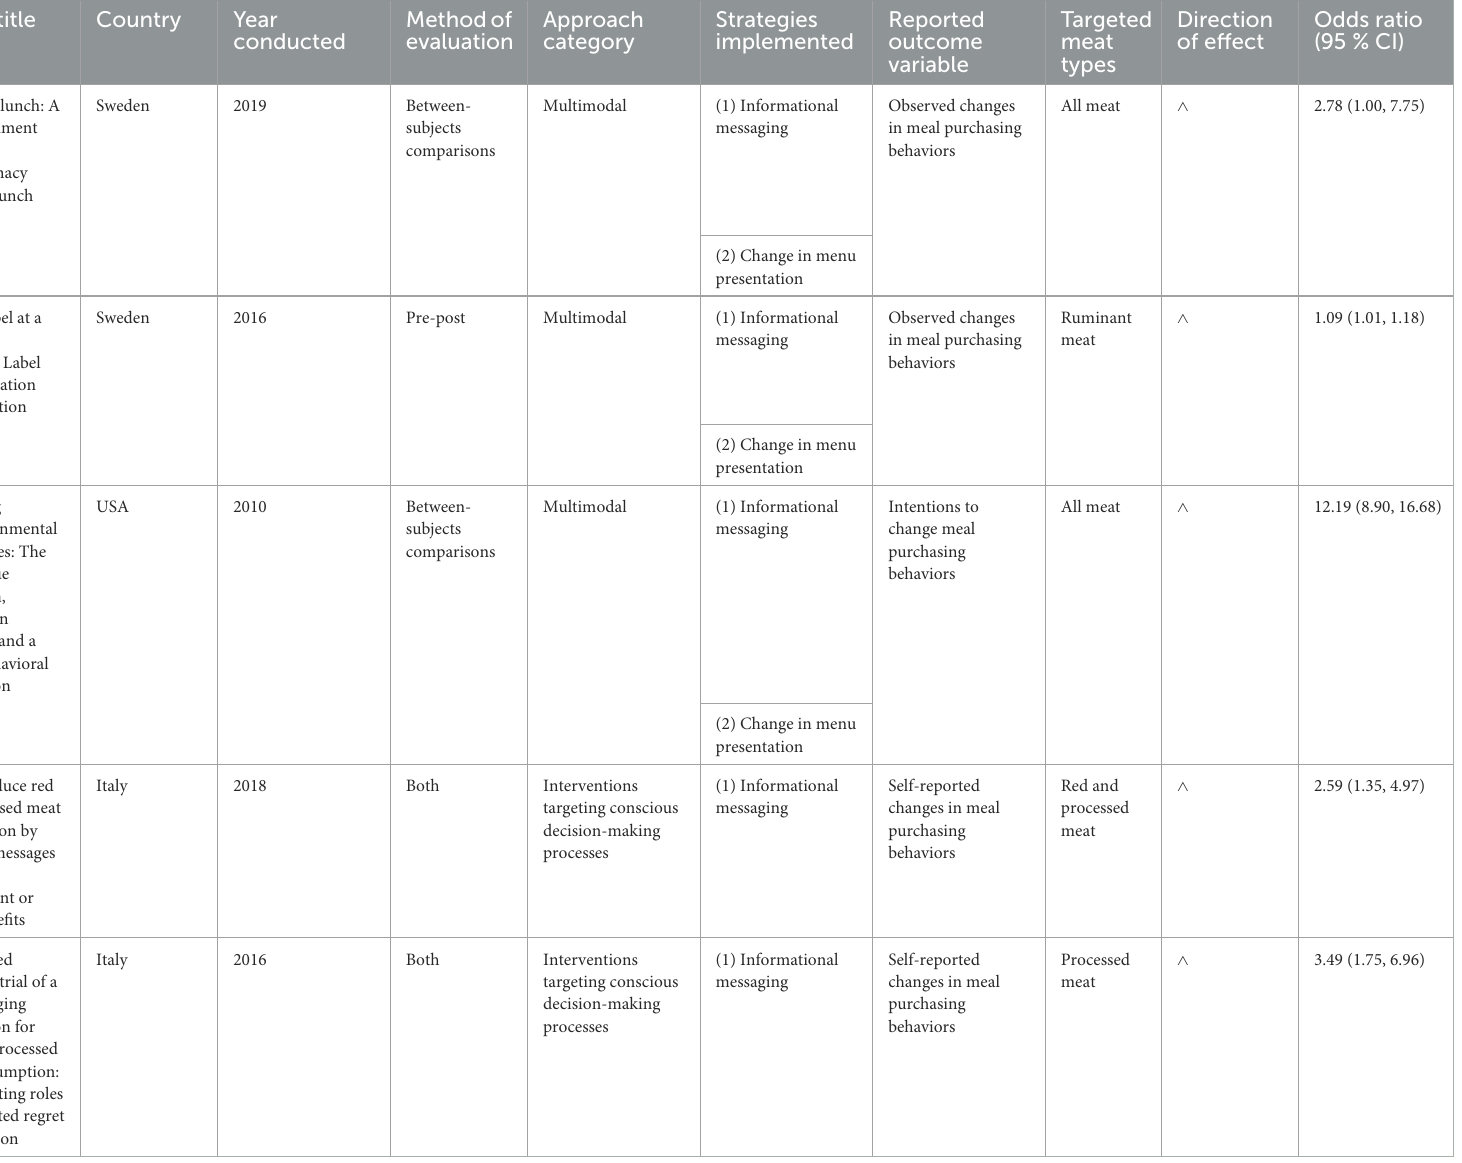
TABLE 1 Summary table outlining the study-level characteristics associated with each of the 31 interventions included in our analyses. Study ( n =